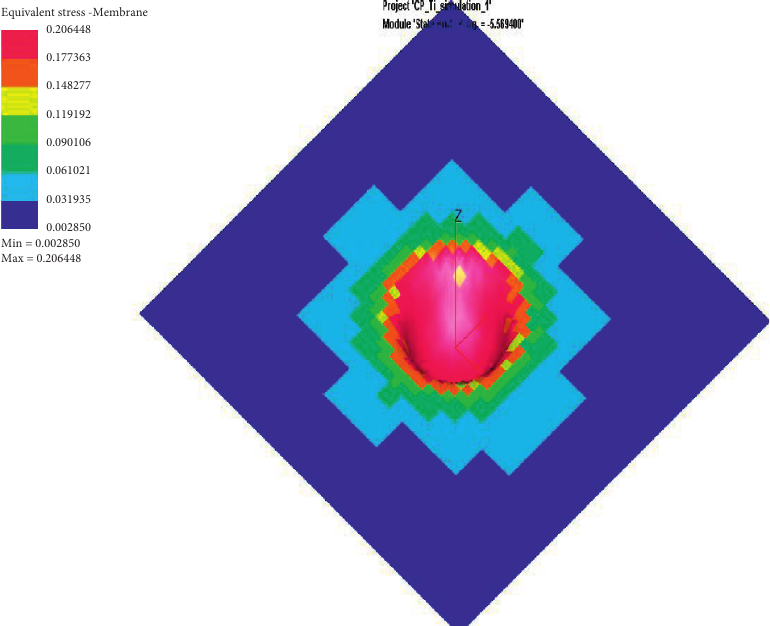
Figure 9: Graph to represent the stress developed on CP-Ti material induced while testing through formability limit diagram (FLD).